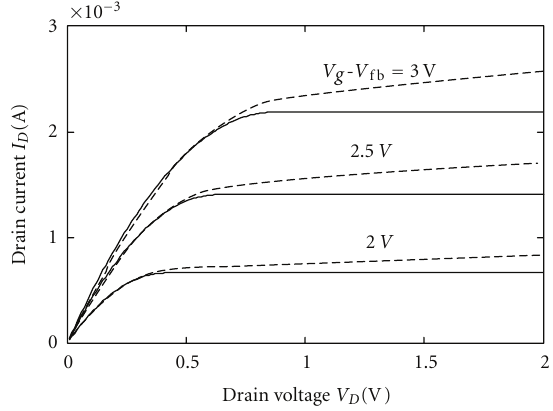
Figure 12: ( I D , V D ): ( − ) (41), ( • ) (43), ( ··· ) (40). ( L = 90nm; W/L = 10.) Figure 13: I D ( V D ): (